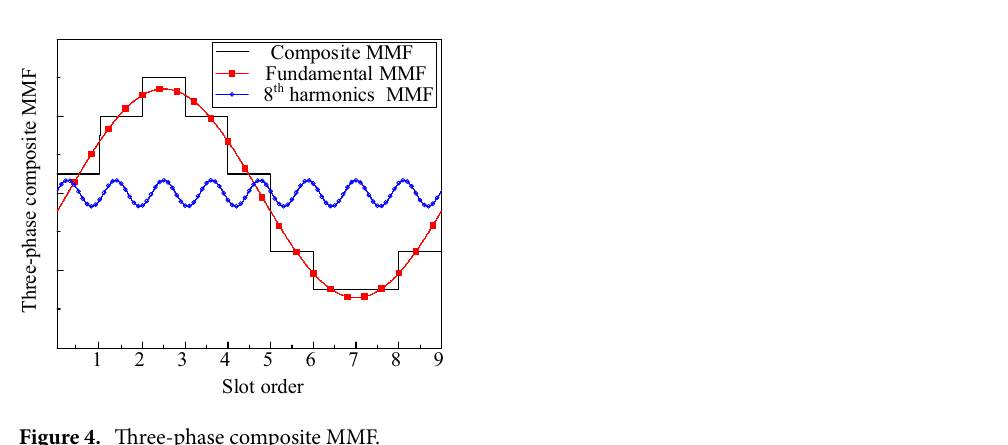
Figure 4. Three-phase composite